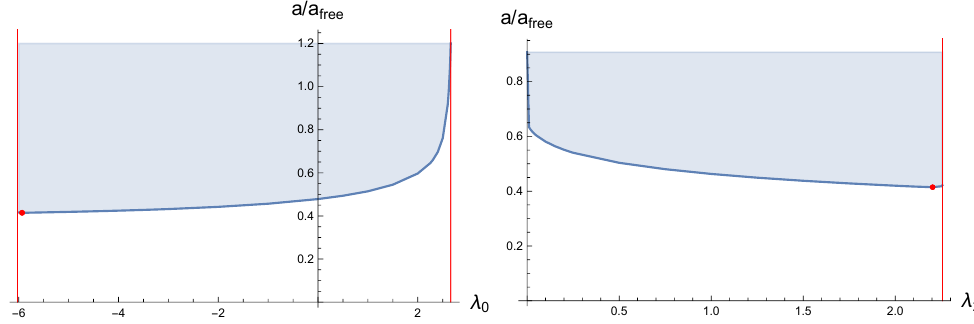
Figure 11 . Lower bound on the a -anomaly as a function of λ 0 in the left plot and as a function of the λ 2 in the right plot. The allowed region is depicted in blue. Red dot represents the point with the lowest value of the a -anomaly. The red vertical lines indicate the boundaries of the allowed regions for λ 0 and λ 2 given in (5.23). The plots are built with N max = 20 and L max = 30 .